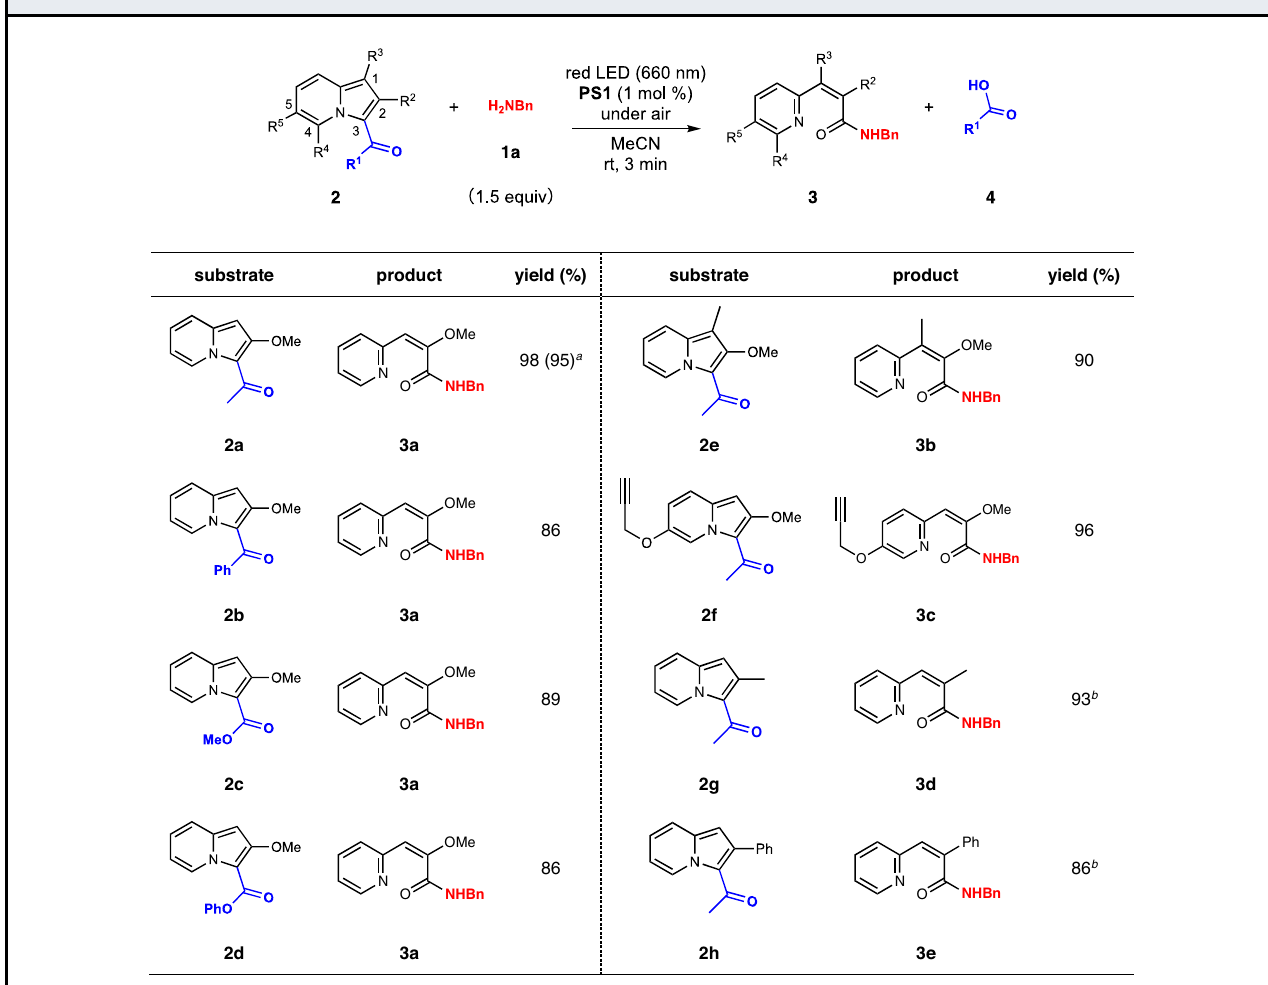
Table 1 Photoreaction of 3-acylindolizines with